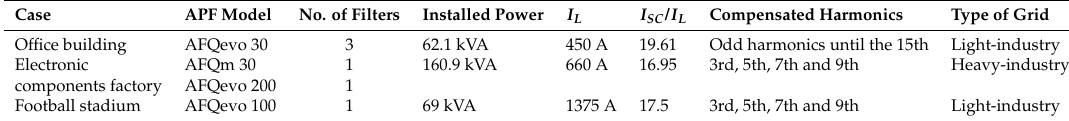
Figure 10. Active power filters used in the experiments. Table 10. Summary of the performed experiments.